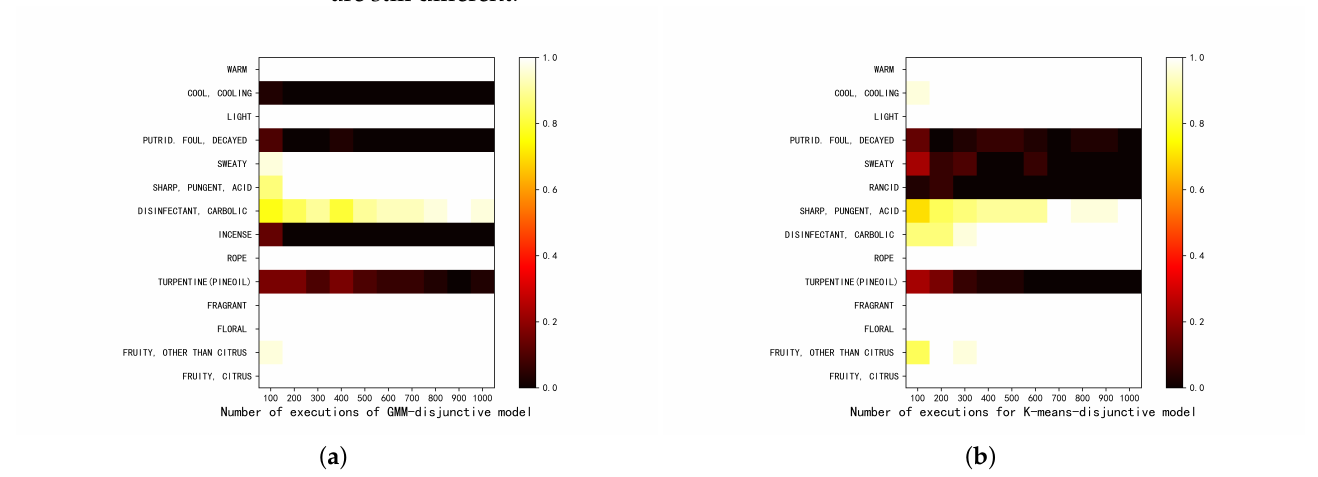
Figure 6. The stability analysis of ten CCOPDs obtained from Gaussian mixture model (GMM)-disjunctive and K-means- disjunctive under different numbers of execution times of clustering algorithms. The color bar on the right indicates the probability of being selected as the clustering-odor perception descriptors. ( a ) The stability analysis of ten CCOPDs obtained from the GMM-disjunctive models under different numbers of execution times of the clustering algorithm. ( b ) The stability analysis of ten CCOPDs obtained from the K-means-disjunctive models under different numbers of execution times of the clustering algorithm.